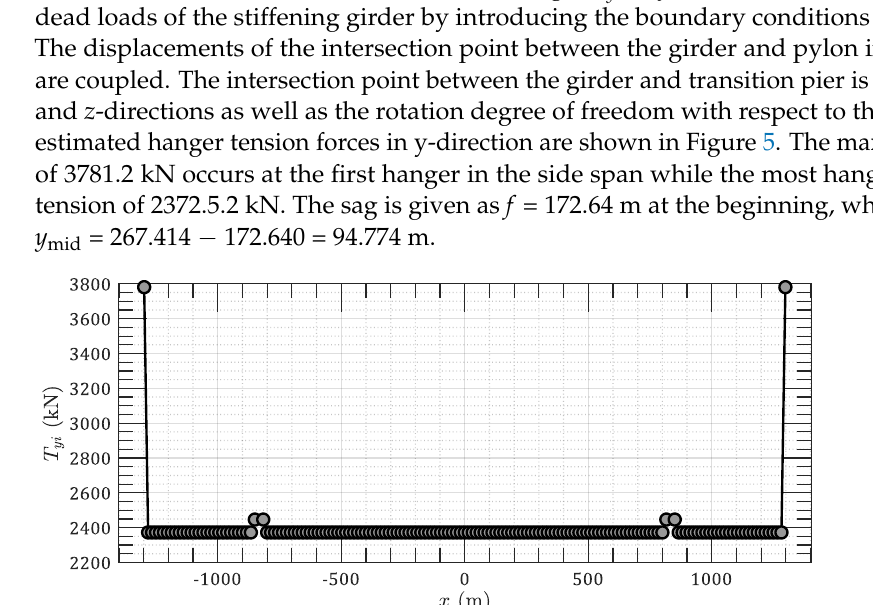
Figure 4. Layout of the suspension bridge using parallel main cables.